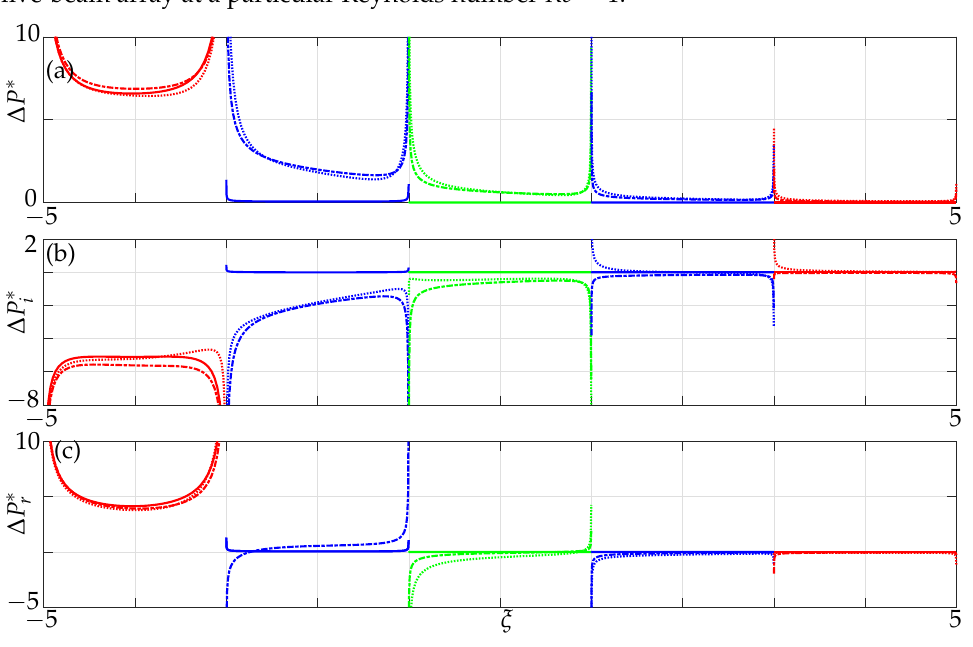
Figure 13. Variation of the ( a ) absolute, ( b ) imaginary and ( c ) real values of nondimensional pressure difference across five beams incorporating only nearest neighbour influence at Re = 1; solid lines: ¯ g = 8, dash-dotted lines: ¯ g = 0.4, dotted lines: ¯ g = 0.1, with the left-most beam active and the rest